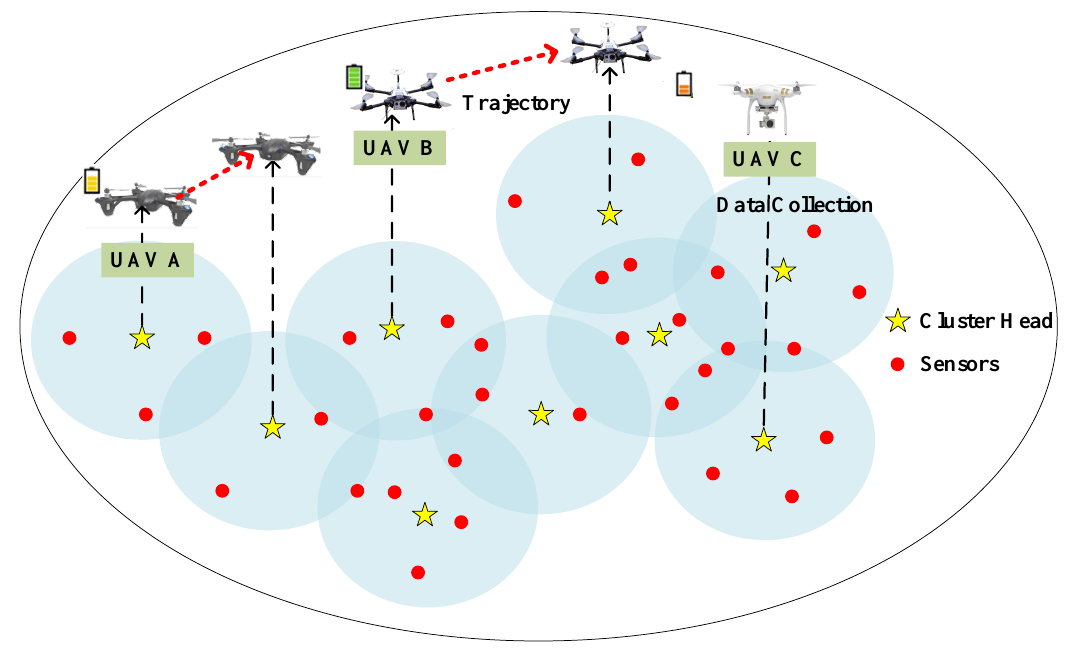
Figure 1. Monitoring